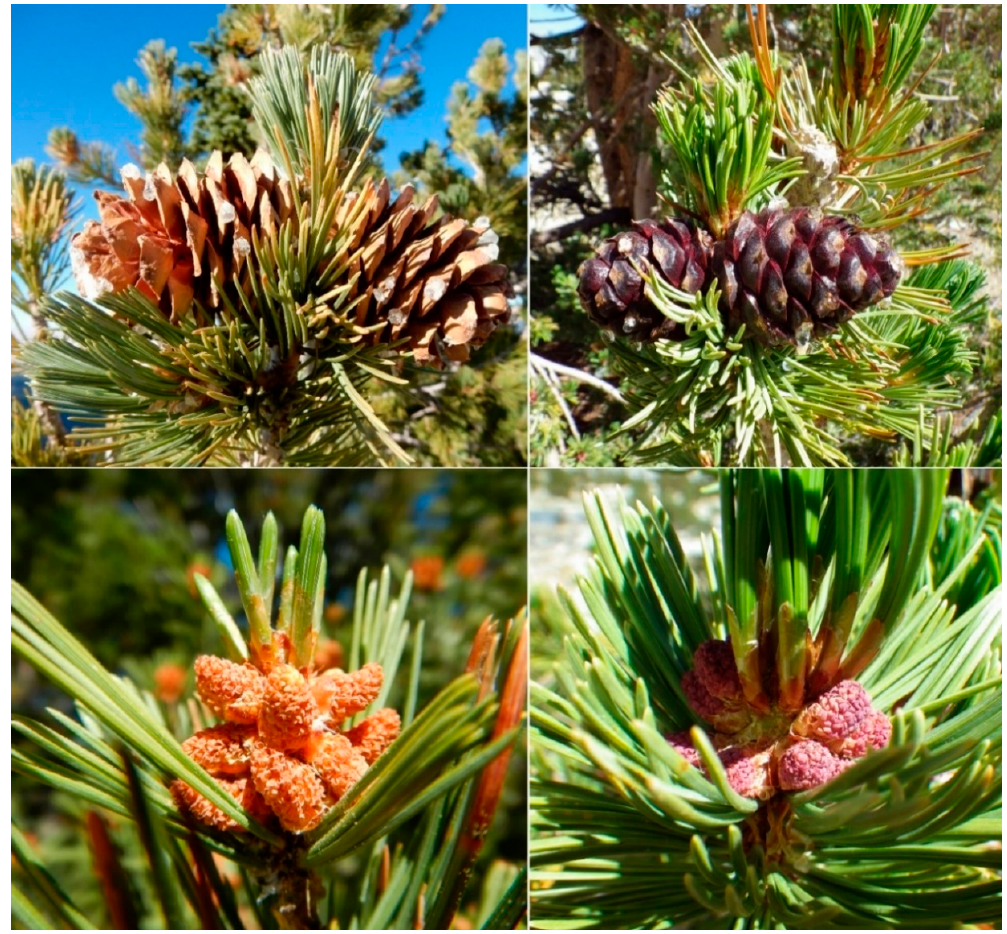
Figure 1. Cones of limber and whitebark pine. Seed cones of limber pine (upper left) and whitebark pine (upper right). Pollen cones of limber pine (lower left) and whitebark pine (lower right). Photos by M. Lavin [5].